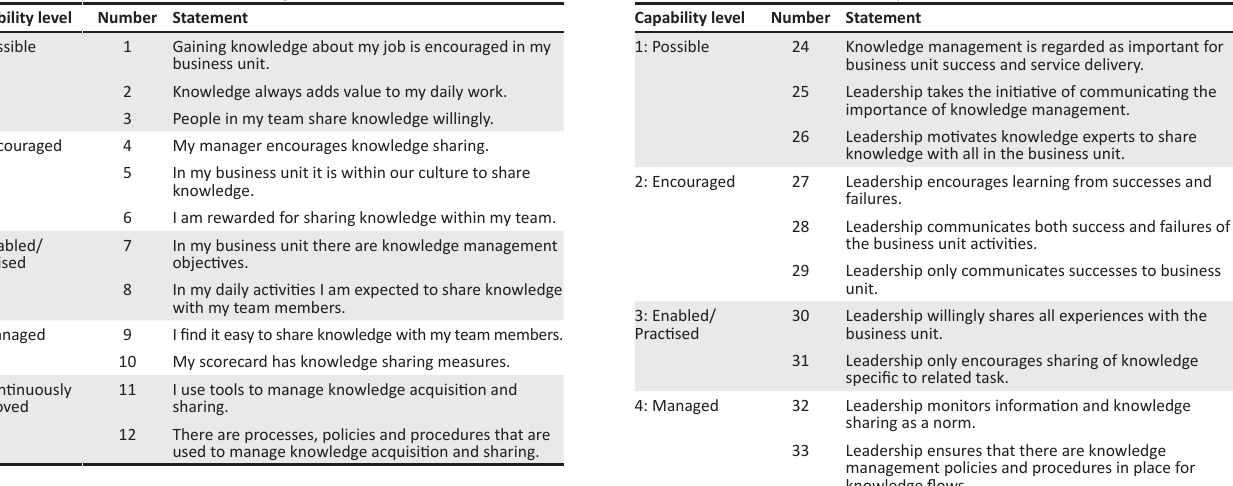
TABLE 3-A1: Question 8: Leadership role.